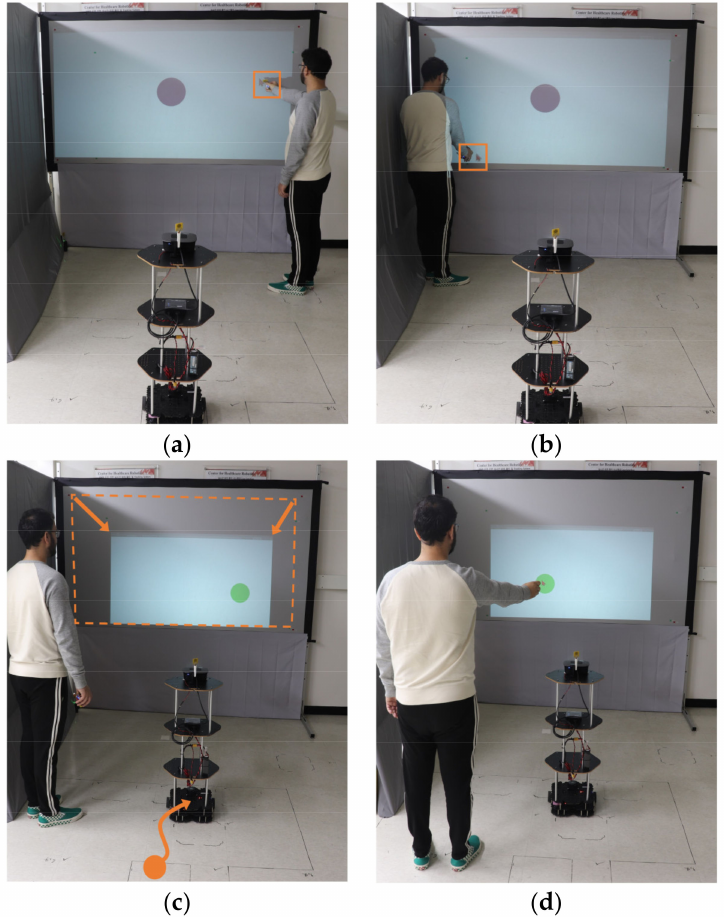
Figure 10. Customizing the projected screen and resuming the interaction: ( a ) The user enters the first point, ( b ) the user enters the second point, ( c ) the USAP moves to customize the projected screen, and ( d ) the user resumes